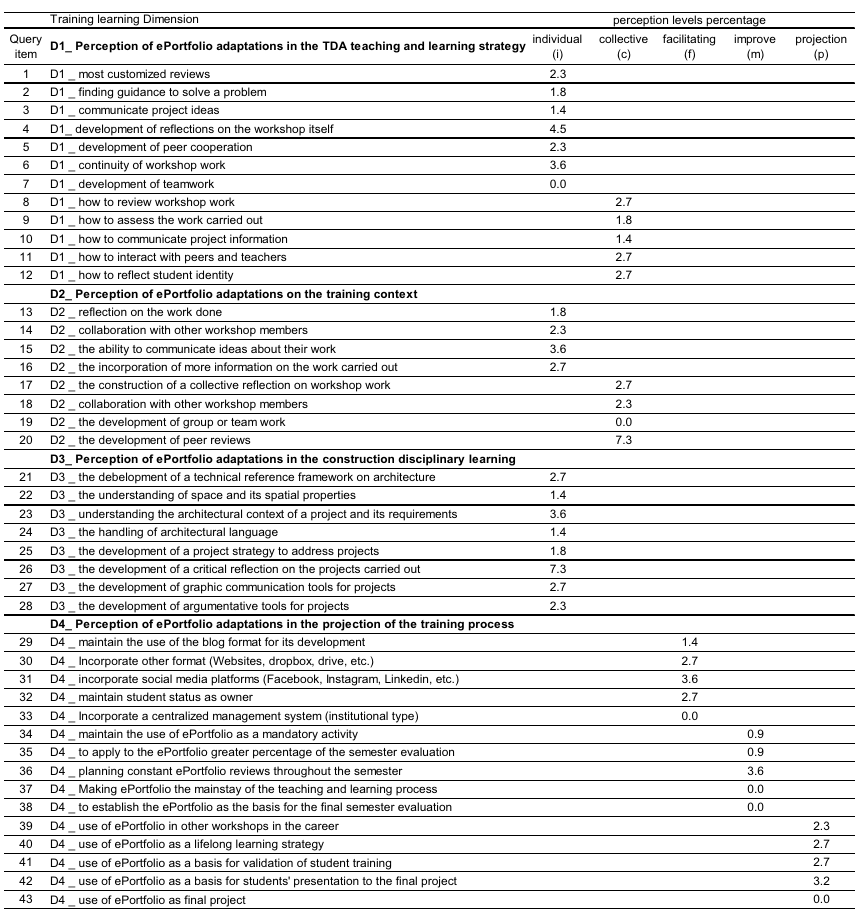
Table 4 Training process dimension incidence in the NLP development